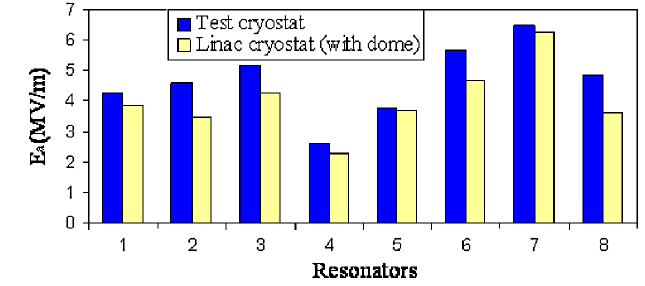
FIG. 8. (Color) Accelerating field performance of the resonators in the test cryostat and the linac cryostat after installation of the